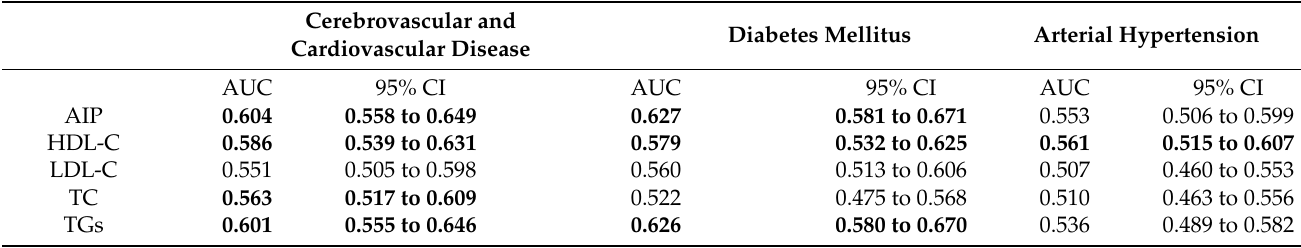
Table 5. The predictive value of lipidic fractions for cerebrovascular/cardiovascular disease, diabetes mellitus and arterial hypertension in patients with